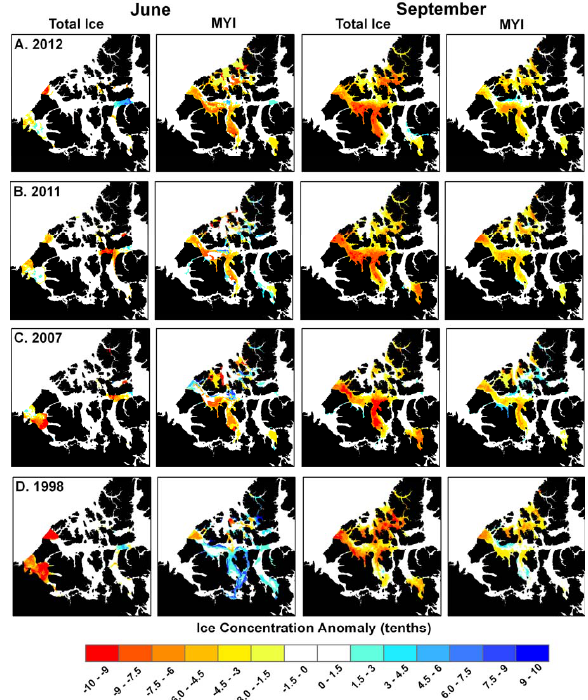
Figure 3. Spatial distribution of June and September total ice and multi-year ice (MYI) concentration anomalies (tenths) for the light ice years of 2012, 2011, 2007 and 1998 within the Fig. 3. Spatial distribution of June and September total ice and Canadian Arctic Archipelago (A-D). Anomalies calculated with respect to the 1981-2010 multi-year ice (MYI) concentration anomalies (tenths) for the climatology.